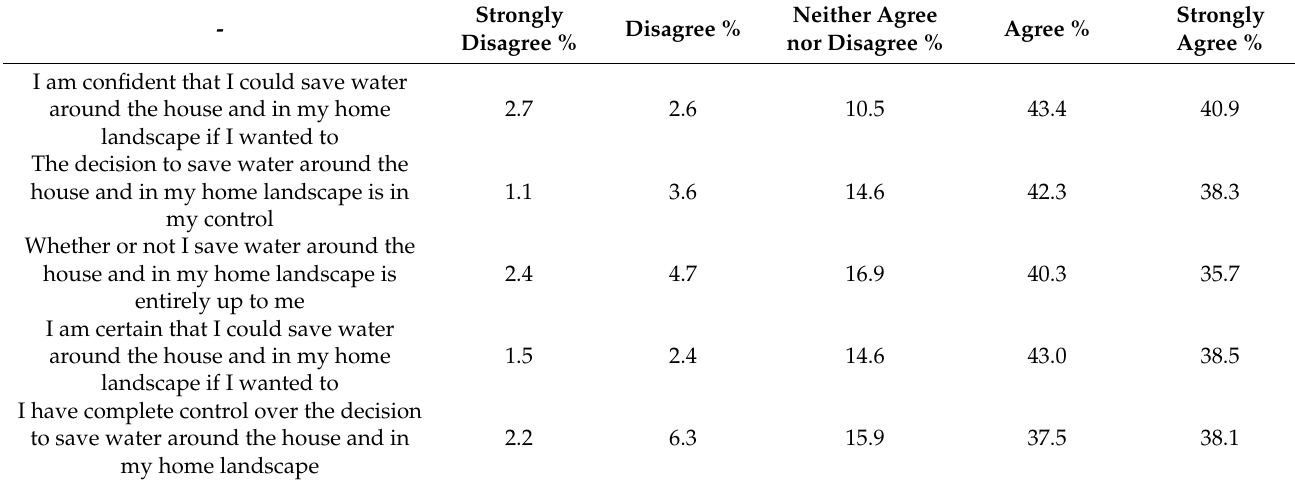
Table 3. Respondents’ perceived behavioral control towards water conservation (N =